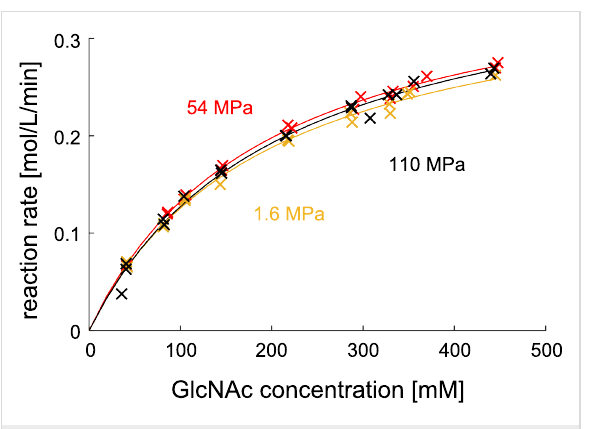
Figure 8: Measured reaction rates of the immobilized epimerase. The dashed line is the fit according to the Michaelis–Menten equation. Conditions: 40 °C, flow rates: 1.6 MPa at 2 mL/min, 54 MPa and 110 MPa at 1.8 mL/min, reactor volume: 0.21 mL, 10 mM potassium